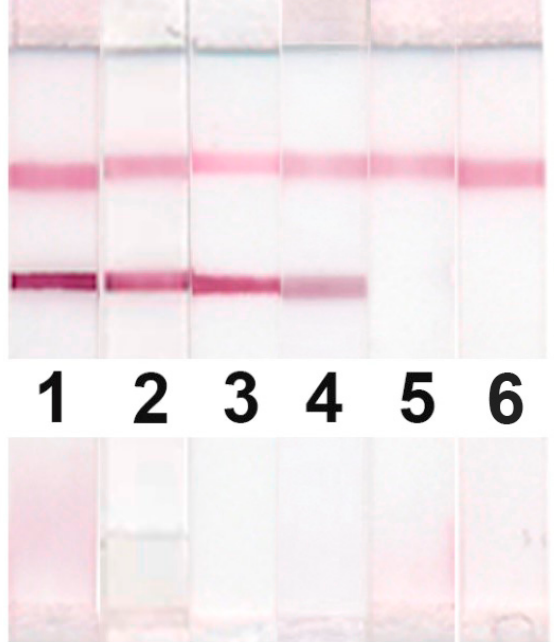
Figure 7. Testing mammalian (1—beef, 2—pork, 3—lamb, 4—horse) and bird (5—chicken, 6—turkey) ten-fold diluted meat extracts by the developed LFIA of TnI (Variant No. 2 of the test system).